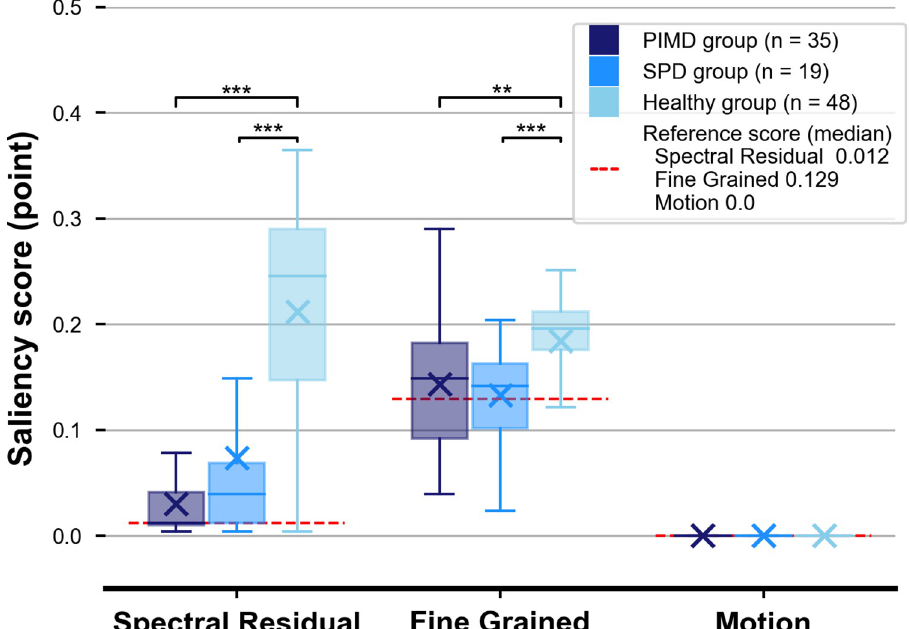
Fig 5. Distribution of saliency scores for the entire video. Distribution of saliency scores for the entire video among the PIMD, SPD, and healthy groups, presented as box-and-whisker plots. Significant statistical differences in spectral- residual and fine-grained scores were observed between the PIMD and healthy groups and between SPD and healthy groups (p < 0.01), respectively. Box-and-whisker plots show median values ( − ), average ( × ), interquartile ranges, minimum and maximum values, and outliers. � p < .05, �� p < .01, ��� p < .001. PIMD, profound intellectual and multiple disabilities; SPD, severe physical